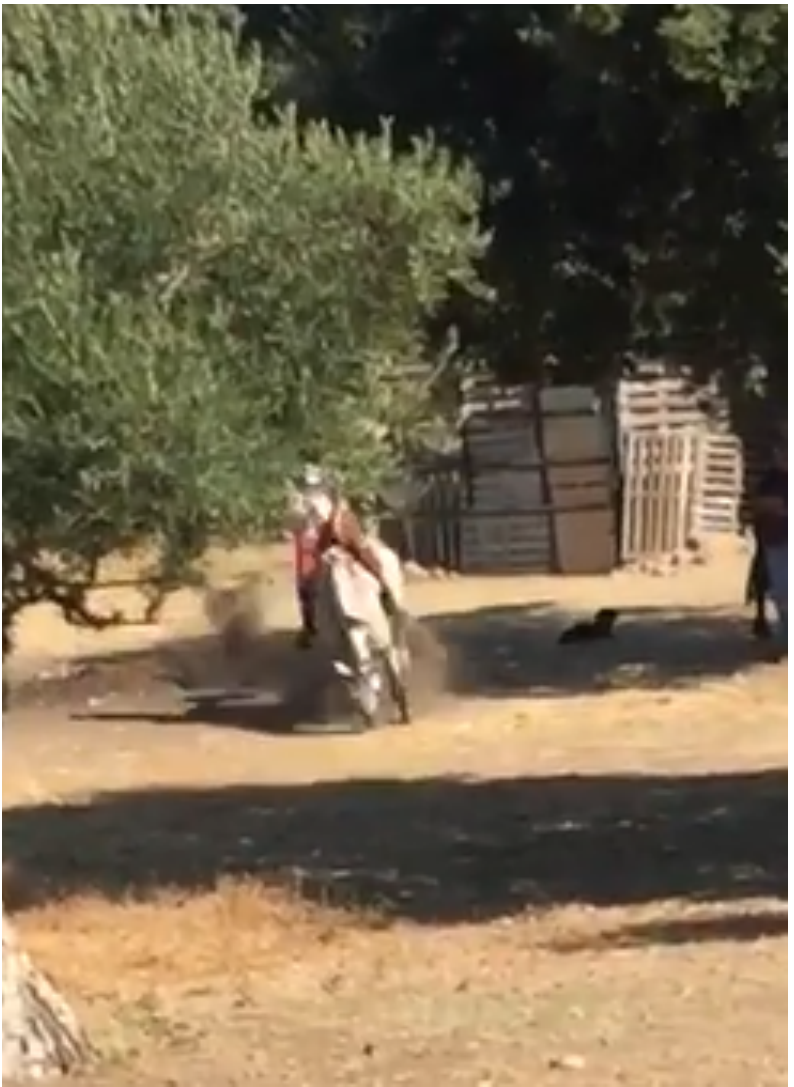
Figure 1. Low quality photogram of a real life video of a horse with an atrial fibrillation collapsing during exercise. We are used to seeing scenes of horses falling to the ground in Western films, but they are not real. The great value of this image is that an amateur video captured the precise moment when the poor horse unexpectedly collapses (its head is very low) and the rider (whose legs are clearly visible and is going to be thrown over the horse’s head). We include the image here despite its low quality because we consider it a real document illustrating the dangers of a horse collapsing during